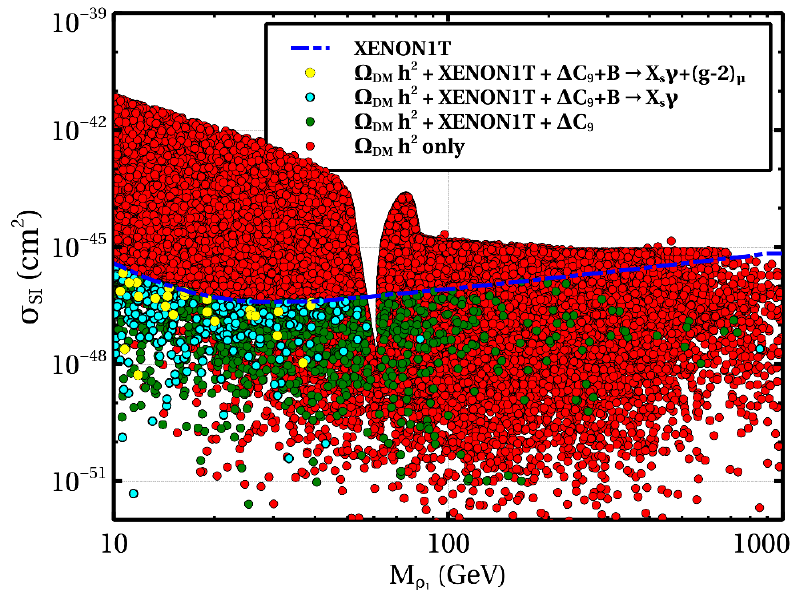
Figure 9 . Allowed parameter space in (cid:27) SI vs M (cid:26) indicated in the